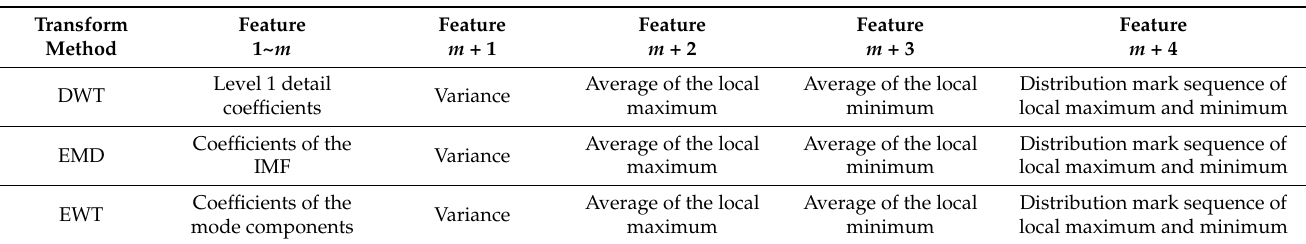
Figure 8. Overview of time-frequency features. Table 1. Composition of the time-frequency